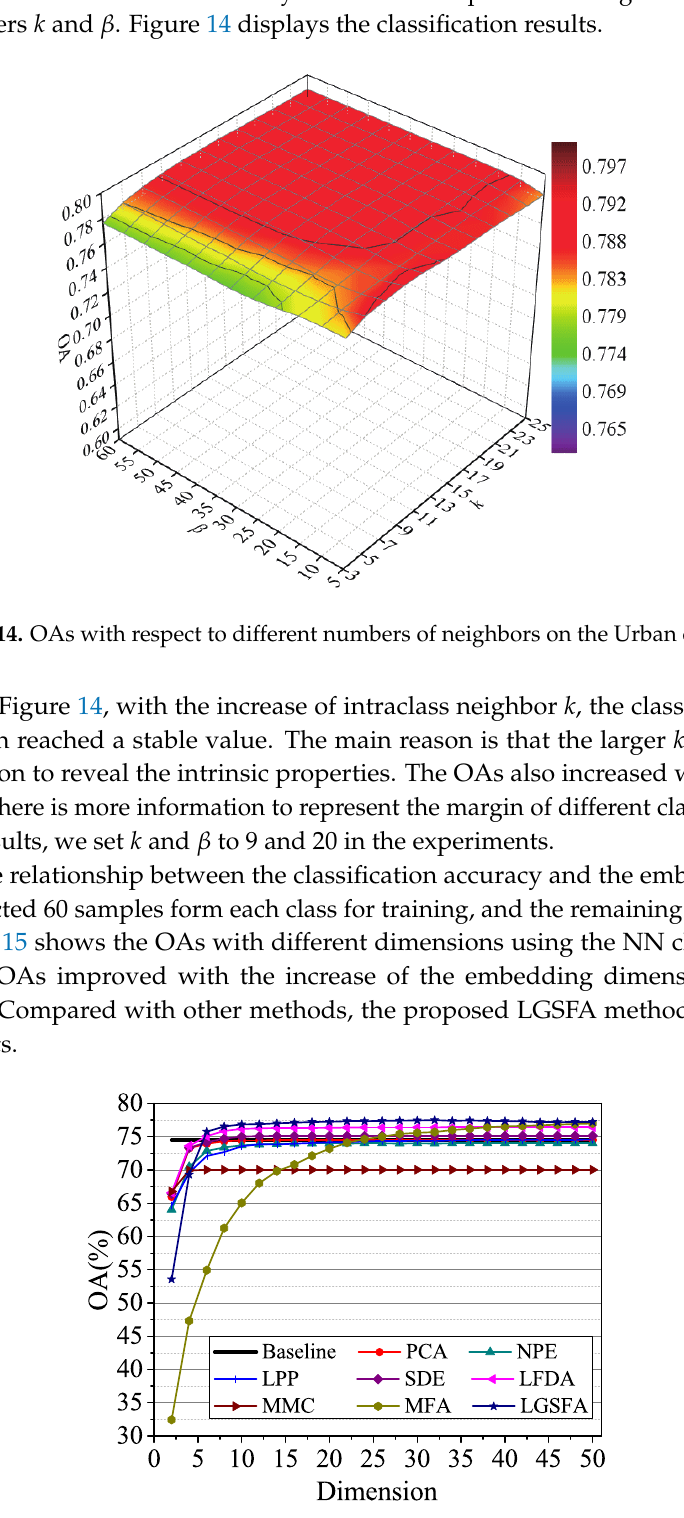
Figure 15. OAs with respect to different dimensions on the Urban data